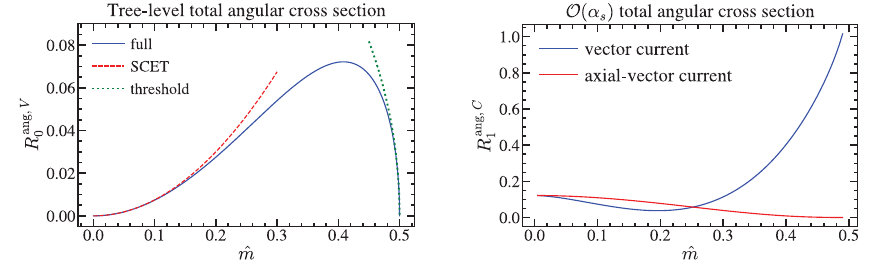
Figure 2: Total angular cross section at LO for the vector current (left panel) and NLO (right panel) for vector (blue) and axial-vector (red)